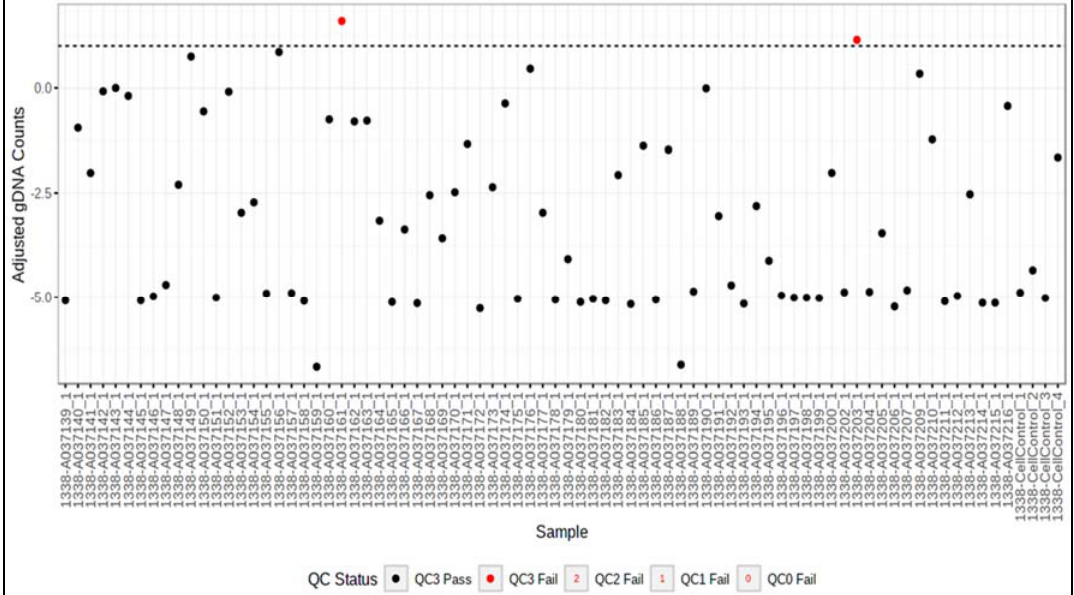
Figure 2. QC3 ‐ Plot of the HTP analysis. Two samples failed QC3 (red dots), which means that the digestion of gDNA did not complete, as they are above the dotted line meaning the threshold.